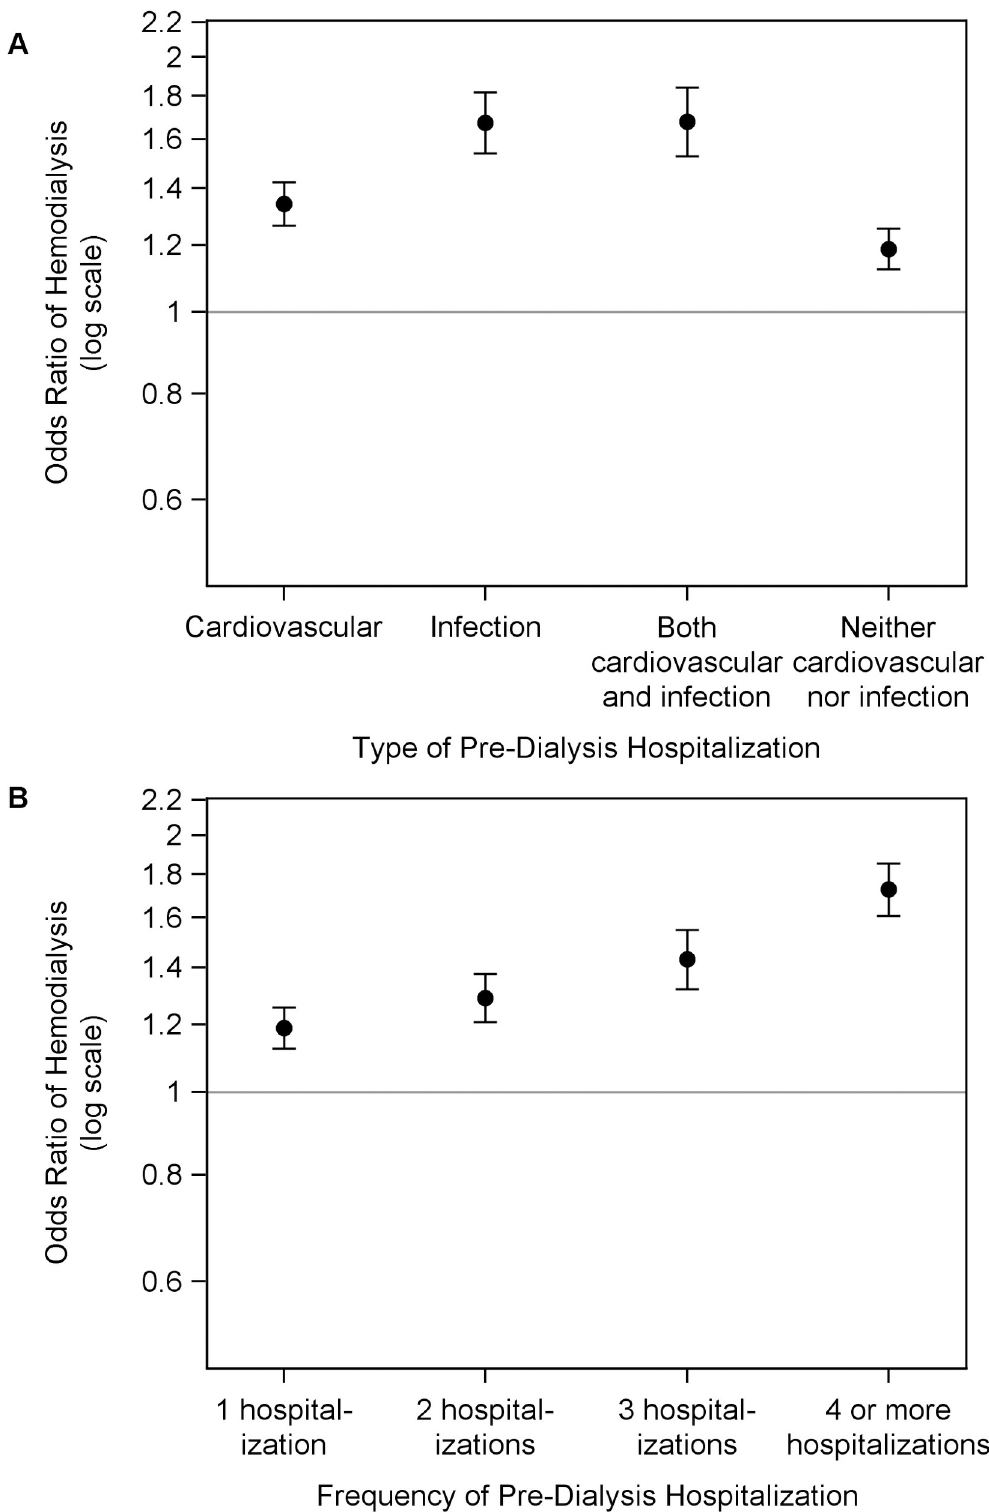
Fig 4. Association of pre-dialysis hospitalization with hemodialysis as the initial dialysis modality among patients with ESRD. Adjusted odds ratio for probability of hemodialysis vs. peritoneal dialysis to initiate hemodialysis by (A) type of pre-